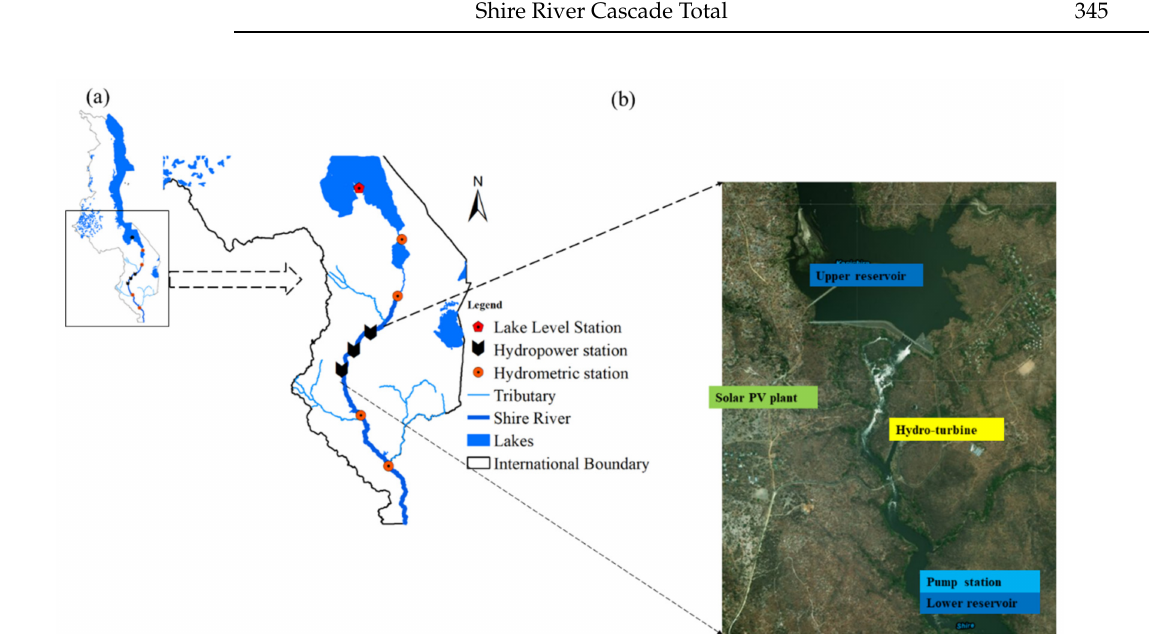
Figure 4. Map of Malawi showing ( a ) Lake Malawi–Shire river system, ( b ) the study location for PHS–PV system along the Shire River, Source: Google Earth images.